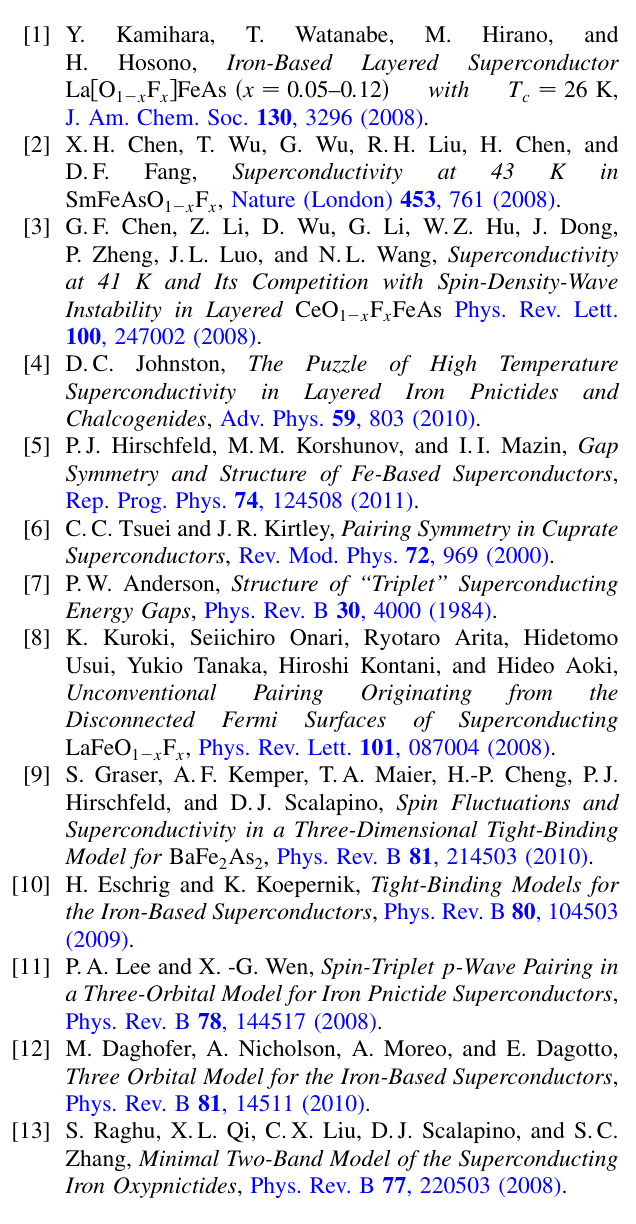
Ladder: Relating the Fe Superconductors to the High- T Cuprates , New J. Phys. 11 , 085007 (2009).